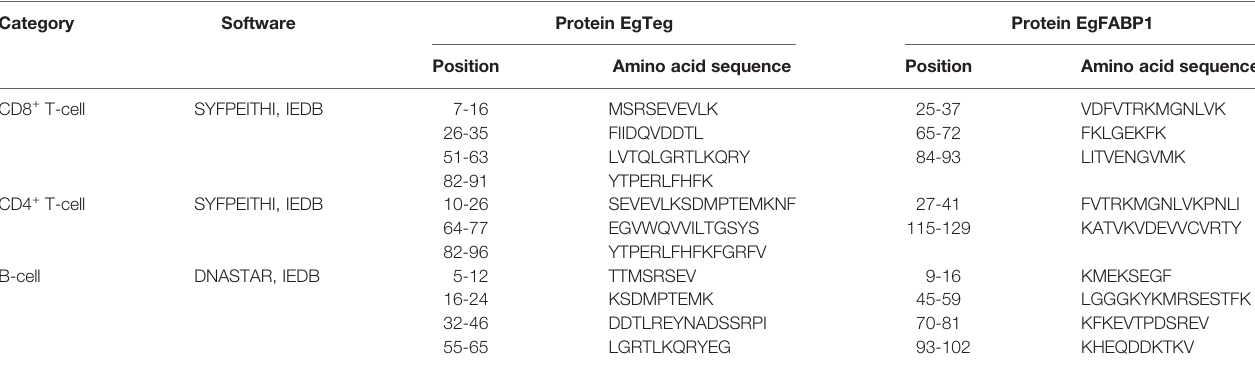
TABLE 1 | The predicted fi nal antigen epitopes of proteins.